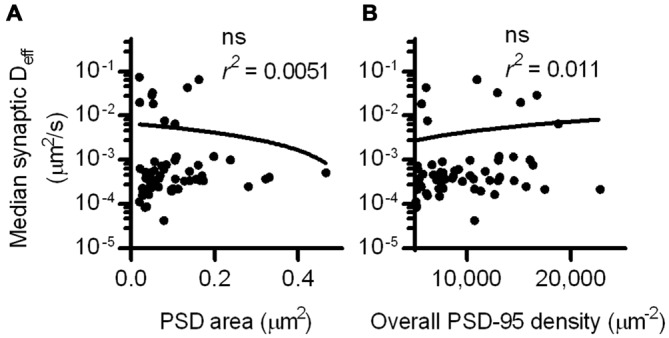
PSD size and density do not correlate with intrasynaptic mobility. (A) PSD area and median Deff within each of the PSDs; linear regression test (n = 113 PSDs/11 cells/3 cultures). (B) PSD-95 density and median Deff within each of the PSDs; linear regression test (n = same as in A).